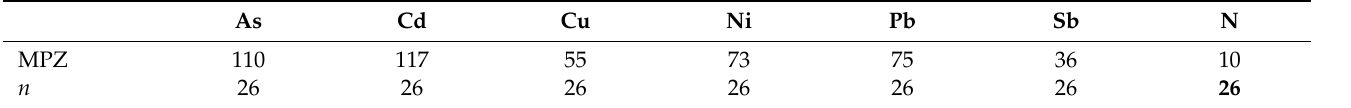
Table 3. Minimum Sample Number (* MSN) and actual sample size ( n **) in MM2020 (* calculated with data from 400 sample points in